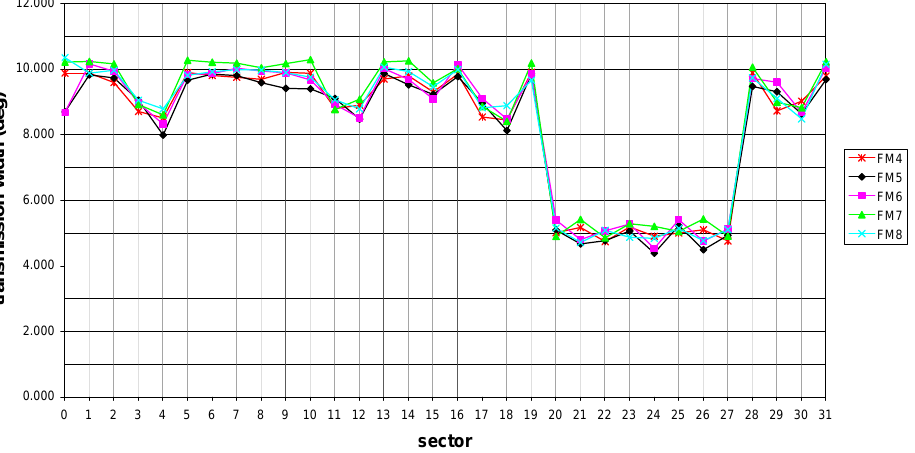
Fig. 6. Beta sector transmission of HIA for the four flight models and the spare model. Results are very similar for the five models. Sectors 0–15 correspond to the High G and 16–31 correspond to the low g . Transmission in sectors 20–27 is divided by two, as expected from the